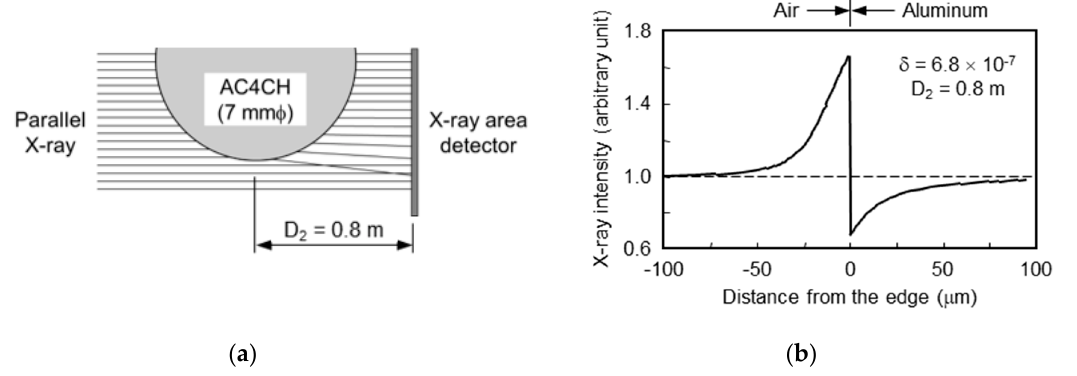
Figure 4. Edge enhancement calculation of the projected X-ray image afforded by phase-contrast: ( a ) The calculative geometry. The sample serves as a concave lens; ( b ) Edge enhancement with bright and dark areas at the boundary.